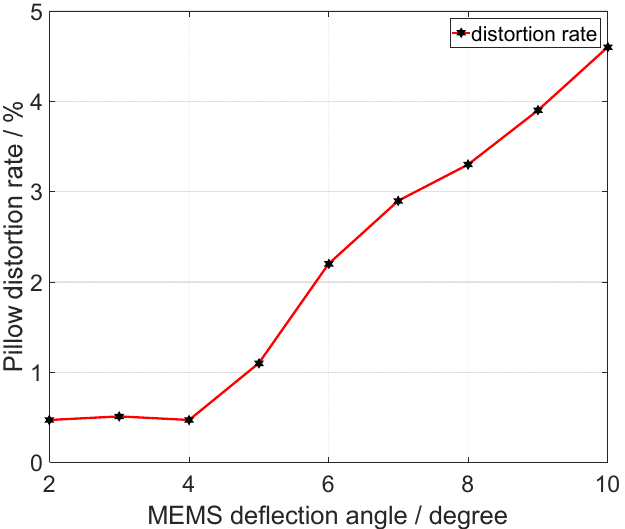
Figure 5. The pillow distortion of reflected light angle varies with the MEMS deflection angle. At the same mechanical deflection angle of MEMS micromirror, when the incident light is incident to the MEMS reflection plane at different angles, the deflection angle of the reflected light changes with the change of the incident angle. As shown in Figure 6, the deflection angle of the outgoing light produces a skew distortion in addition to a pil- low distortion at this moment. The skew distortion is manifested in a dense dot pattern on the left side and a sparse dot pattern on the right side. The change of the incident angle brings about the cause of the skew distortion. It can be seen that the skew distortion in- creases from 6.38 to 9.09% when the incident angle increases from 20 ° to 30 ° while keep- ing the MEMS mechanical deflection angle at −5 ° ~5 ° . The deflection of the 2D MEMS micromirror has the problem of deflection order of two axes; if the order is different, it